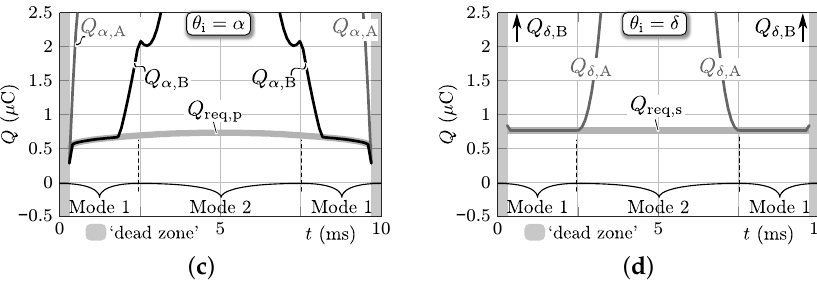
Figure 6. Resulting value trajectories of several quantities calculated for a half cycle of the nominal ac input voltage ( V ac = 230 V rms , 50 Hz) at the nominal ac input current of I ac = 16 A rms (positive power flow) and the nominal dc output voltage of V dc,2 = 400